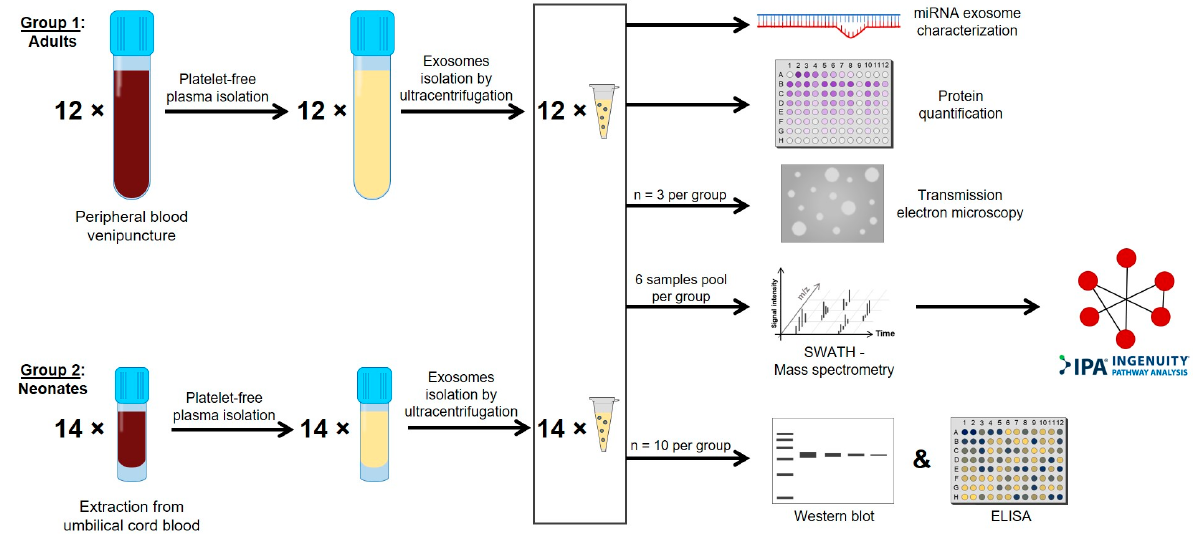
Figure 1. Workflow diagram. Representation of the sequential steps followed blood extraction to exosomes isolation and characterization, and analysis of results.